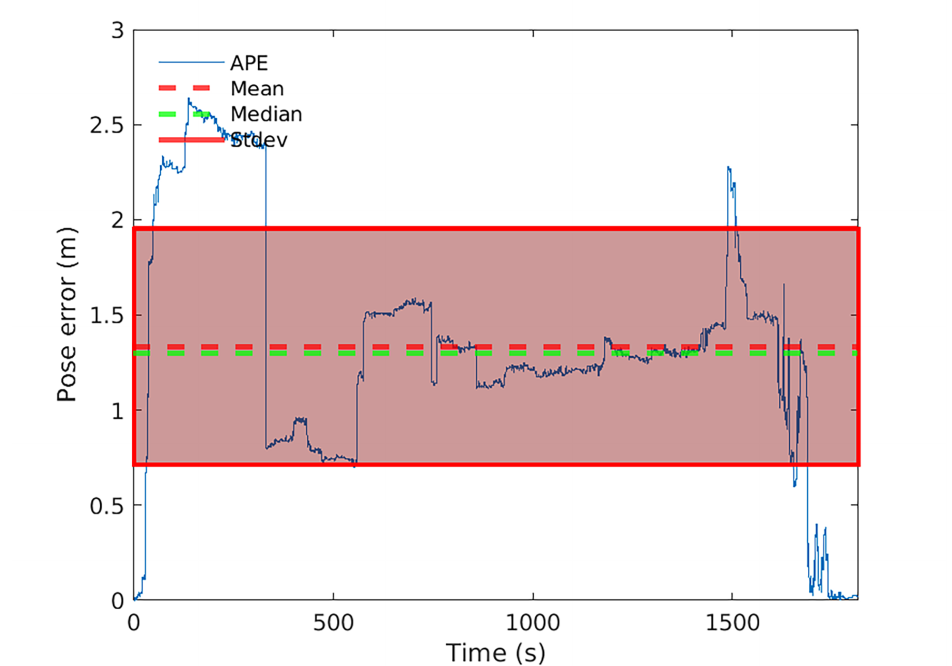
Figure 15. Pose error timeseries evolution for Gmapping on observation